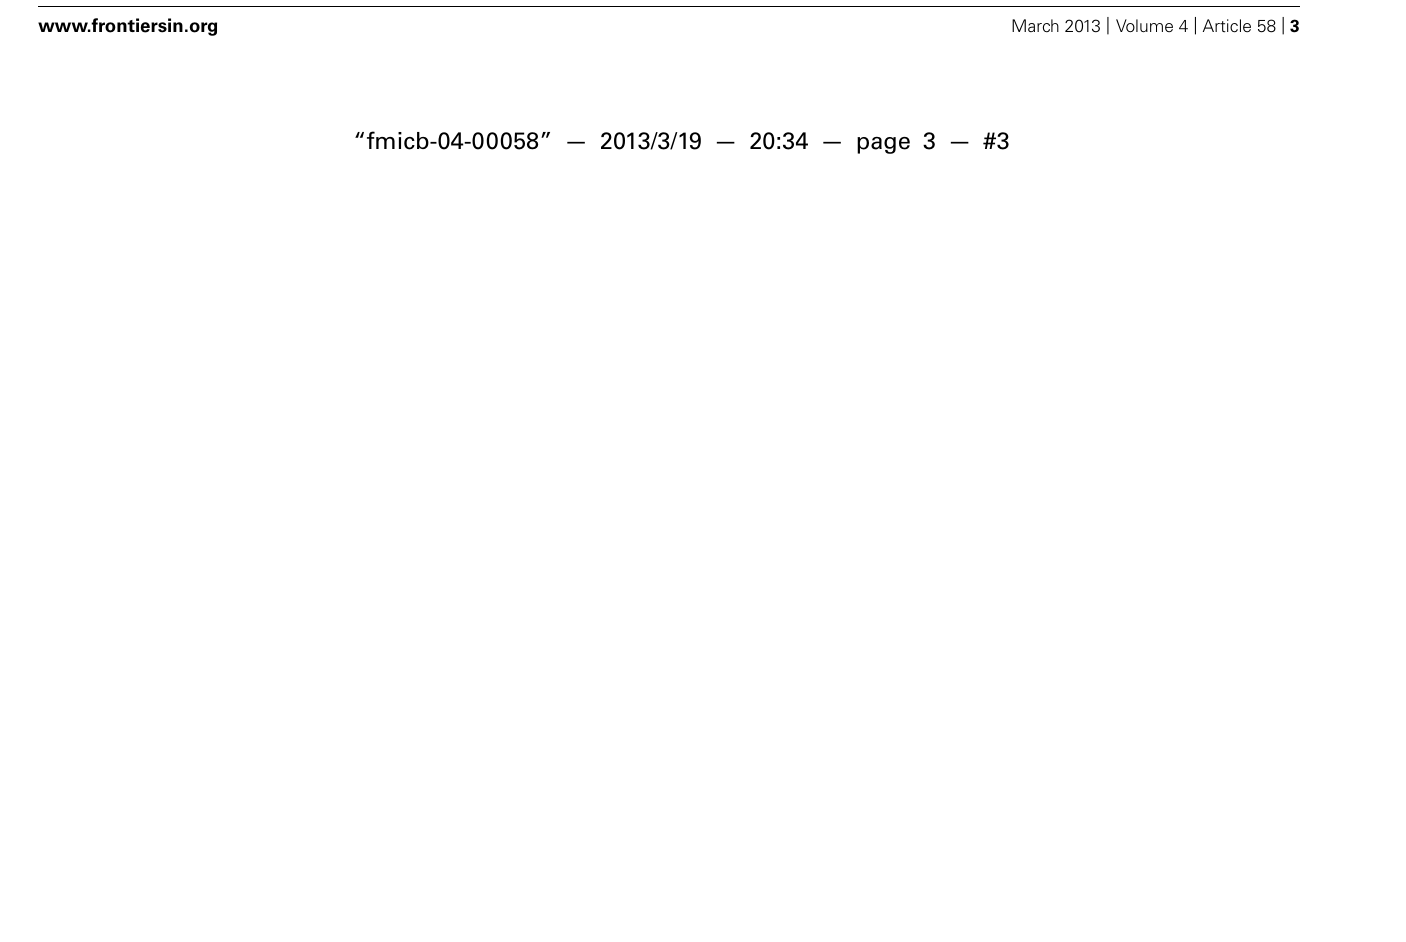
carboxylation has only been found in the sulfate-reducing bacterium strain Hxd3. For short-chain n -alkanes, such as propane, please refer to Kniemeyer etal.